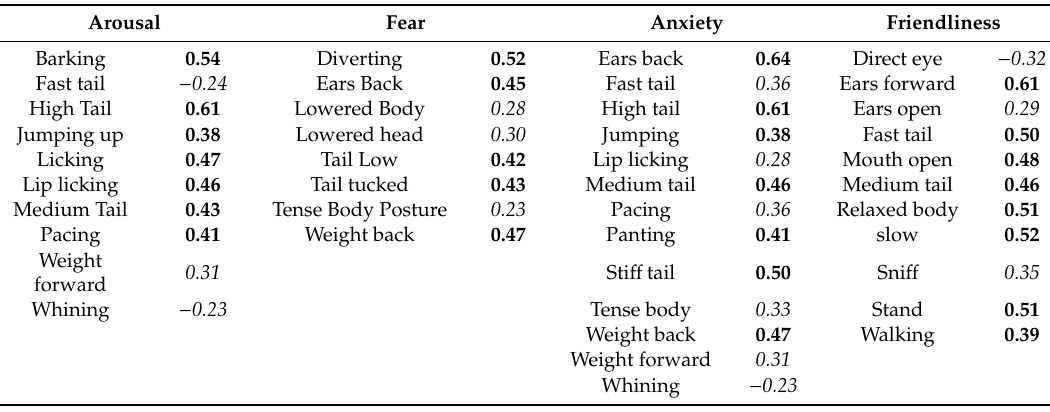
Table 9. Significant ( p < 0.05) Spearman Rank correlation coe ffi cients between behaviours recorded in kennel and behaviours exhibited during the time alone test in the behaviour assessment of shelter dogs ( n = 38) within the emotional domains of arousal, fear, anxiety, and